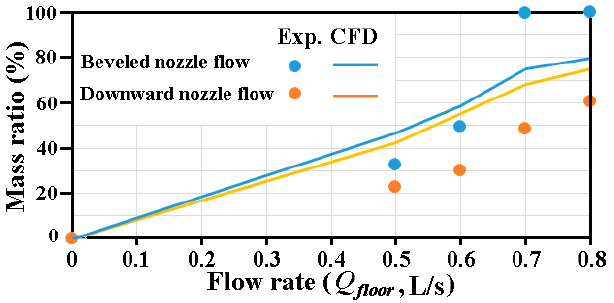
Figure 10. Variations of mass ratio between intercepted and supplied glass balls against Q(cid:4662) (cid:2916)(cid:2922)(cid:2925)(cid:2925)(cid:2928) .